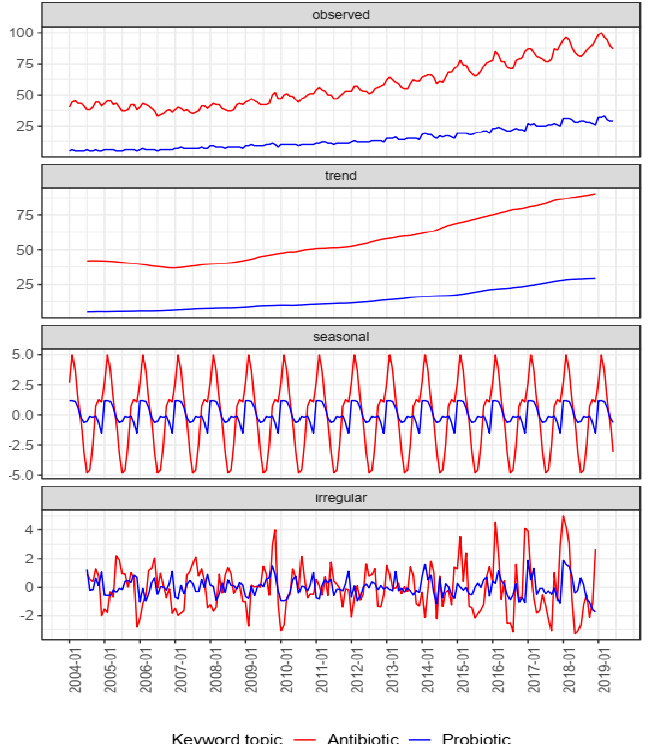
Figure 1. Relative search volume (RSV) of topics “antibiotic” and “probiotic” worldwide from January 2004 through June 2019, and the time series decomposition analysis by Loess. The x -axes of all of the mini-figures are the same periods. The y -axes are expressed in RSV. The mini-figure “observed” presents the course over time of the RSV of the topic. The mini-figure “trend” presents the trend over the analyzed period. The mini-figure “seasonal” presents the seasonal component of the time series “observed”. The mini-figure “irregular” presents the variability, independent from the main trend and seasonal variation.